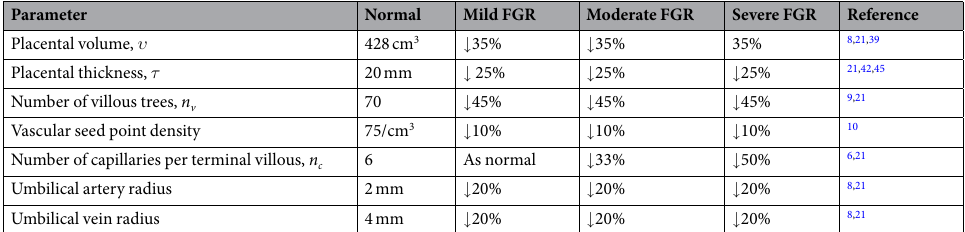
Table 1. Parameters used to generate normal and pathological placental hemodynamic